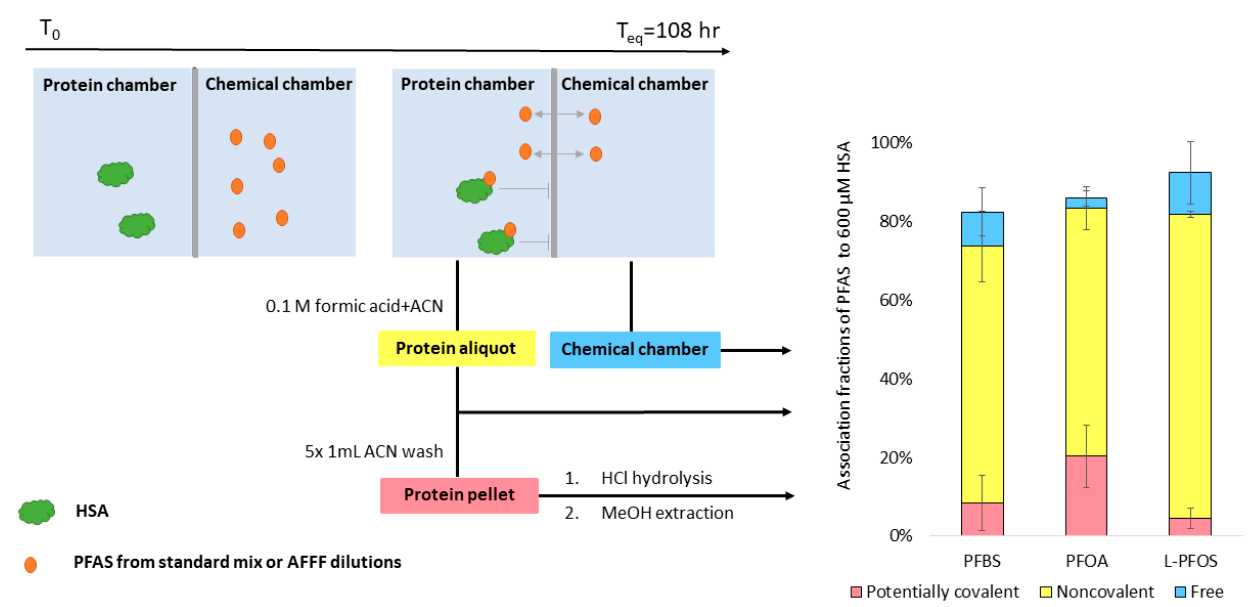
Figure 1. Equilibrium dialysis set-up and observed mass balance for three PFAS with initial dosages of 40–80 ng. PFAS that were free in aqueous solution PFAS, noncovalently bound PFAS, and residual PFAS in the precipitated protein pellet were measured independently. The time required to reach equilibrium (T eq ) was previously determined using 26 PFAS standards in Figure S1.2. Detailed mass balance data are available in Table S1.1.